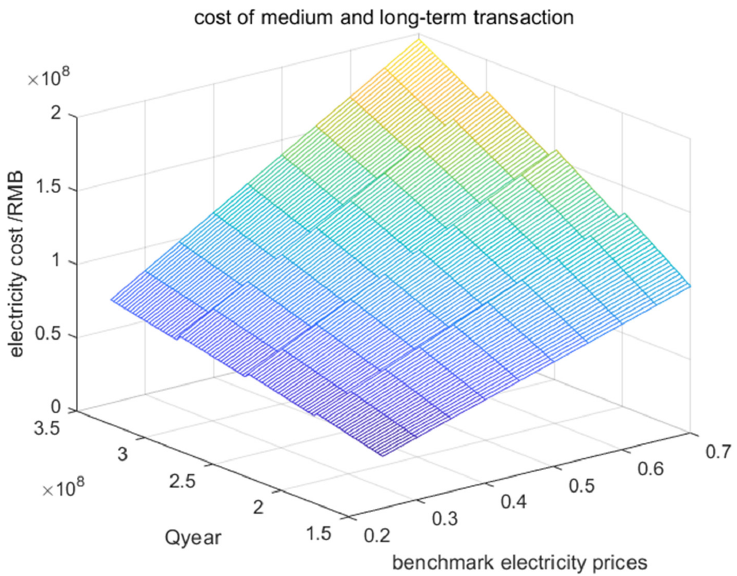
Figure 16. Medium- and long-term electricity costs with different electricity quantities and bench- mark